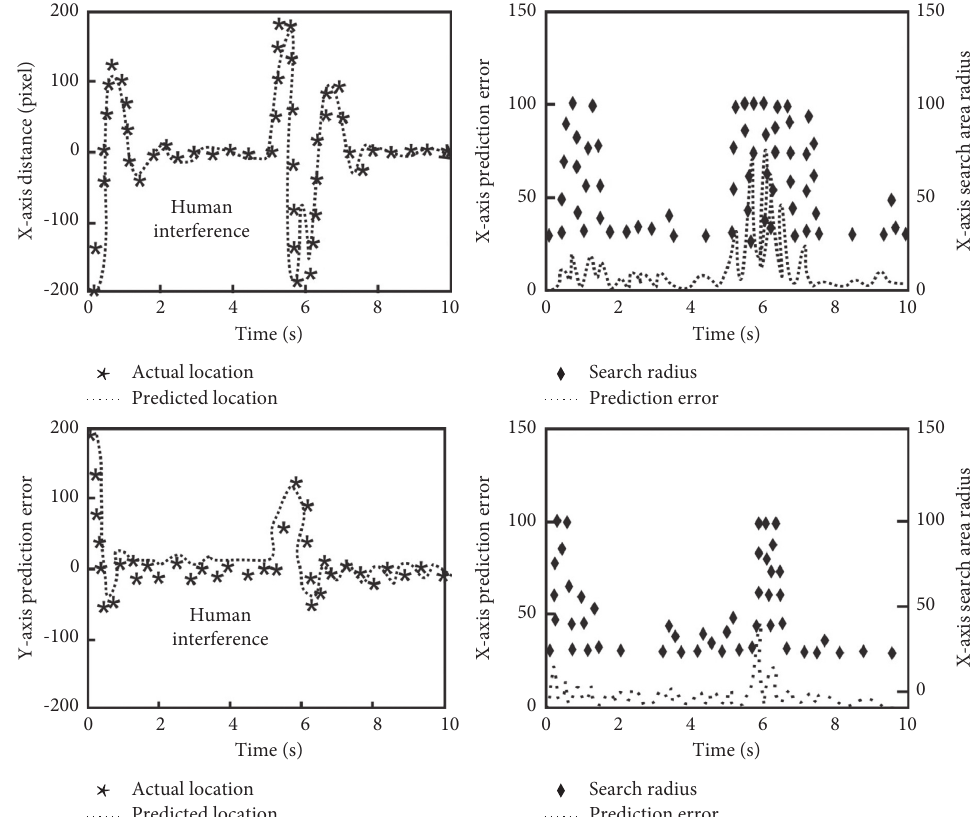
Figure 7: Real-time analysis performance of CAD-assisted intelligent technology athletes’ posture.